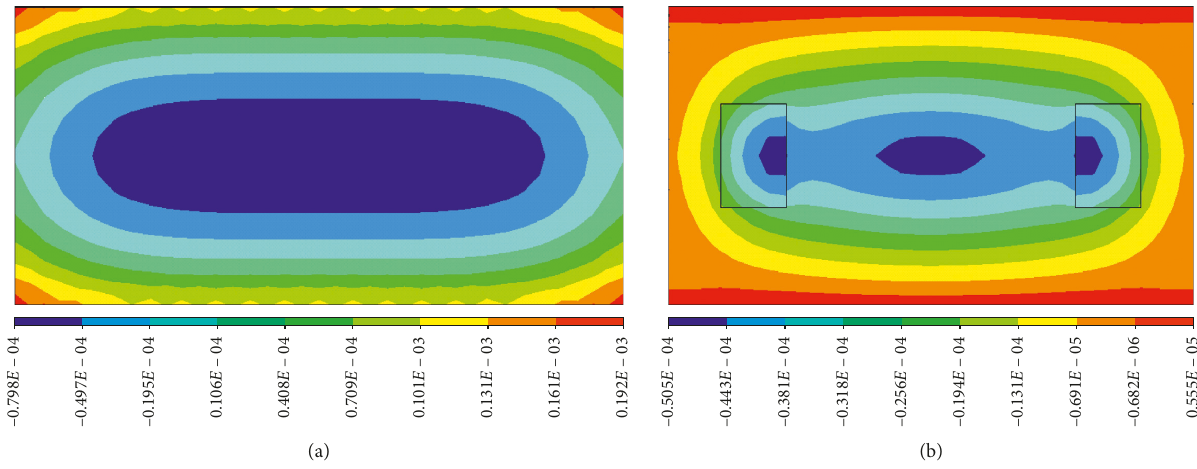
Figure 13: The deformation under